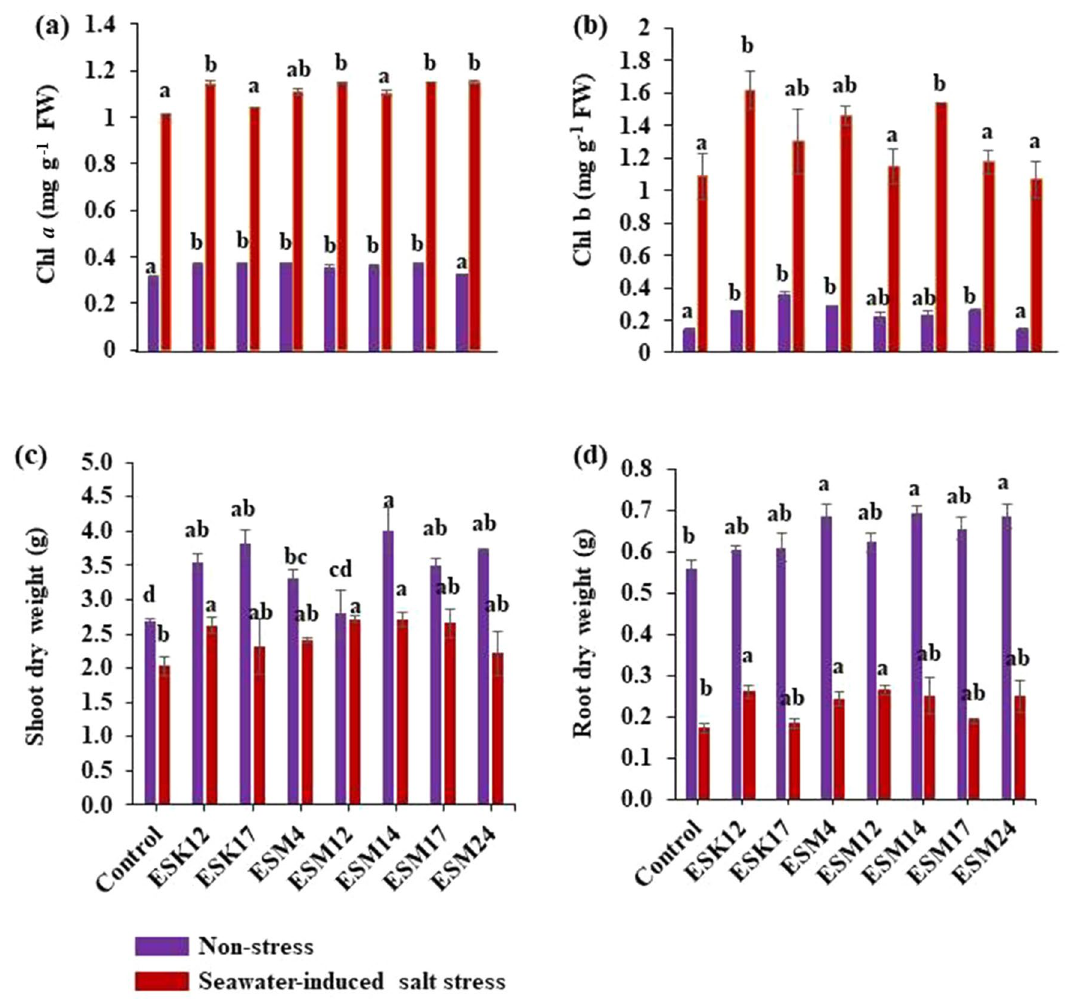
Figure 7. Effects of PGPR inoculation on the biomass accumulation and chlorophyll contents in tomato plants, grown under non-stress and seawater-induced salt stress conditions. Pot-grown tomato plants were inoculated with bacterial strains two times as described in “Methods” section. Analysis of ( a ) chlorophyll a content, ( b ) chlorophyll b content, ( c ) shoot dry weight, and ( d ) root dry weight. Blue and red bars in the graphs represent non-stress and seawater-induced salt stress. Values [mean ± standard error (SE)] of each treatment were attained from three biological replications ( n = 3). Different letters represent significantly different data according to Fisher’s least significant difference (LSD) (P < 0.05). FW fresh